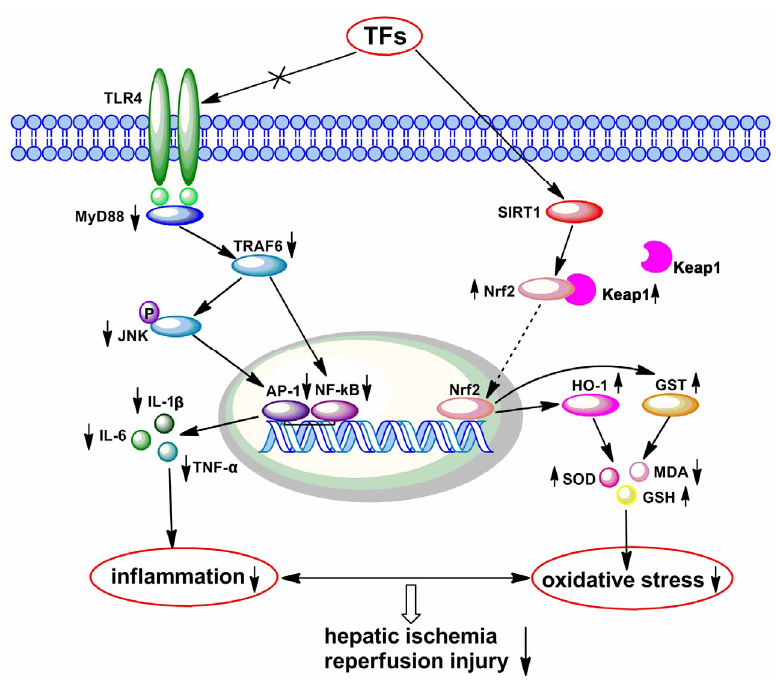
Figure 7. Proposed model for the protective effects of TFs against hepatic I/R injury. TFs alleviated liver I/R damage by regulating oxidative stress and inflammatory reactions through the inhibition of TLR4/MyD88 signaling and the activation of Sirt1/Nrf2 signaling.